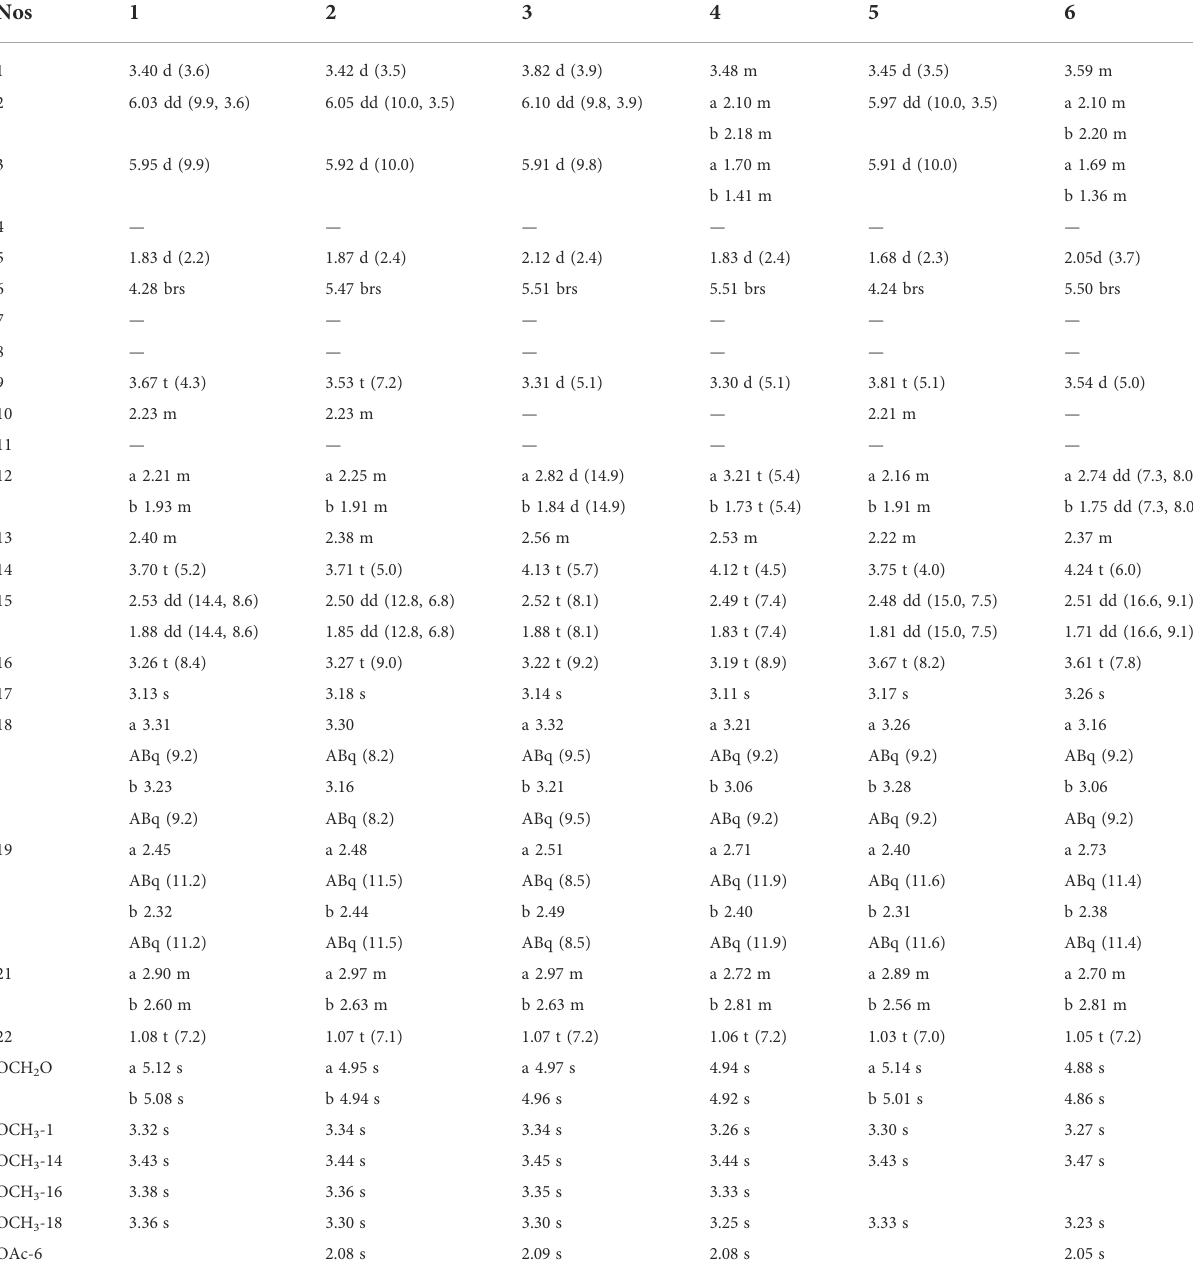
and H-12 β . The β -orientation of OH-6 was deduced from the NOESY correlation between H-1 β and H-10 β , and between H-1 β and H-12 β . The orientations of the remaining oxygenated substituents are identical for all lycoctonine-type DAs, namely, the α -orientation of OCH 3 -14 and the β -orientation of OCH 3 -16, OCH 3 -18, and OCH 2 O (Ablajan et al., 2018). Hence, the structure of 1 was established with the assigned NMR data in Tables 1,